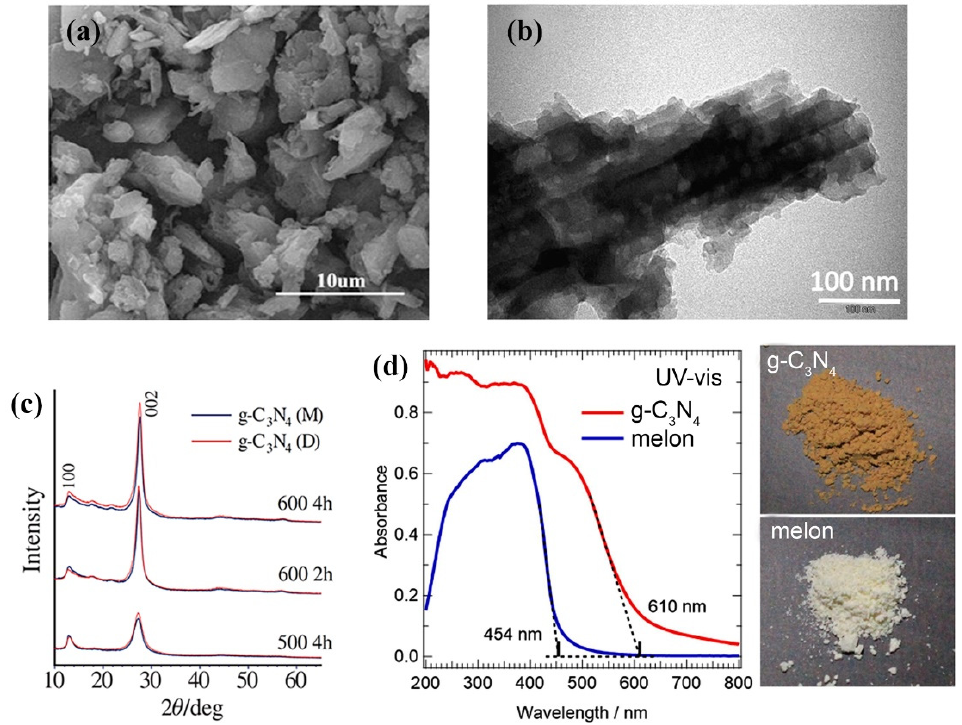
Figure 5. ( a ) SEM image of g-C 3 N 4 prepared from melamine. Reprinted with permission from [26],